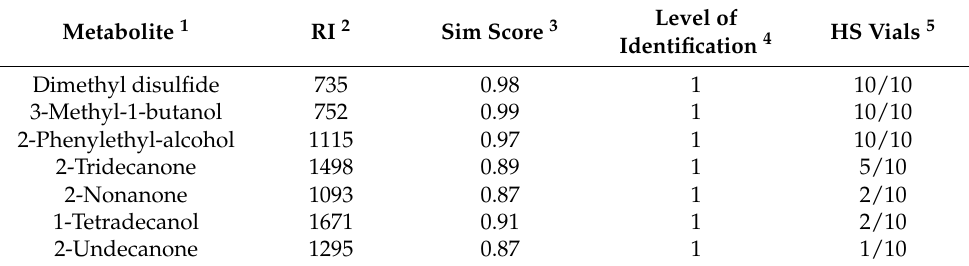
Table 1. Volatile organic compounds (VOCs) detected by gas chromatography-mass spectrometry (GC-MS) in the headspace of vials inoculated with Pantoea agglomerans MVC 21 and incubated for six days. Metabolite 1 RI 2